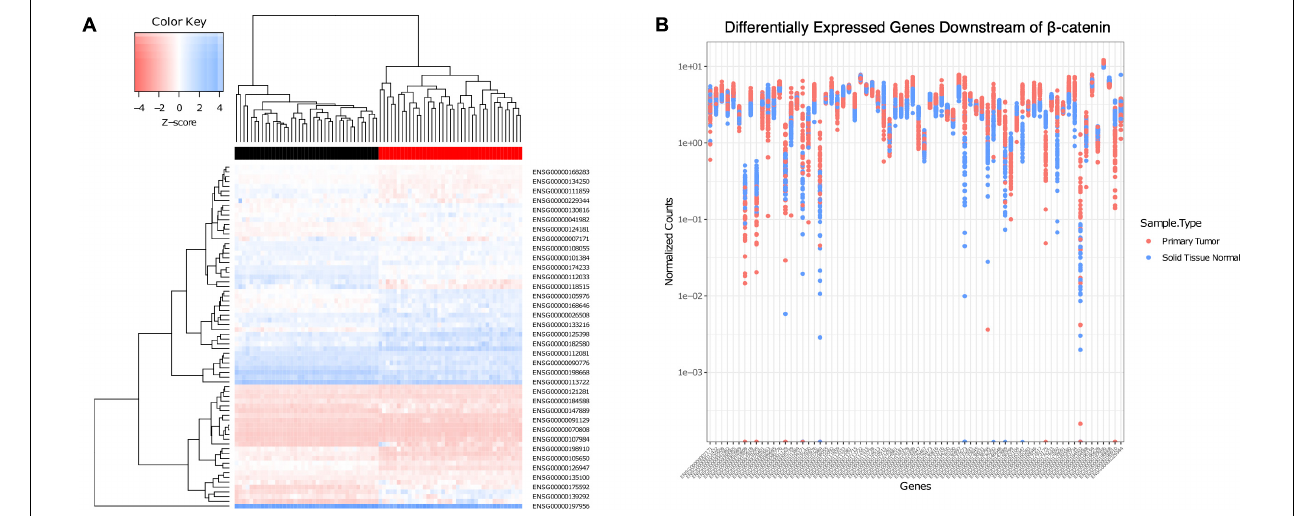
FIGURE 2 | Association of CHRM1 expression with multiple β -catenin signaling genes predictive of cancer status. (A) A heatmap of expression profiles of 72 β -catenin downstream genes demonstrated unsupervised clustering of samples into adenocarcinoma (red) or normal (black) tissue. (B) Individual gene expression levels were assessed in each sample, and levels in adenocarcinoma samples were found to be, on average, more varied across all samples.